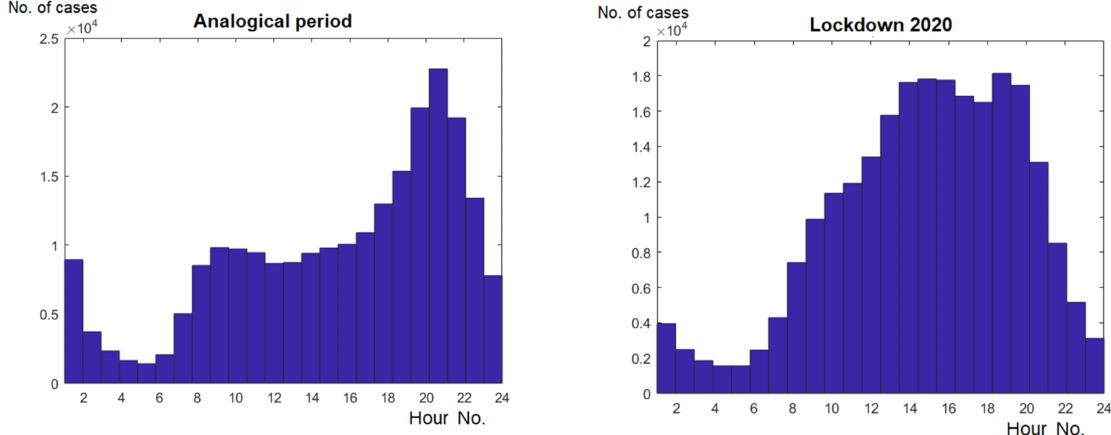
Figure 7. Histograms of peak load hour of active power during the lockdown and the analogous period in